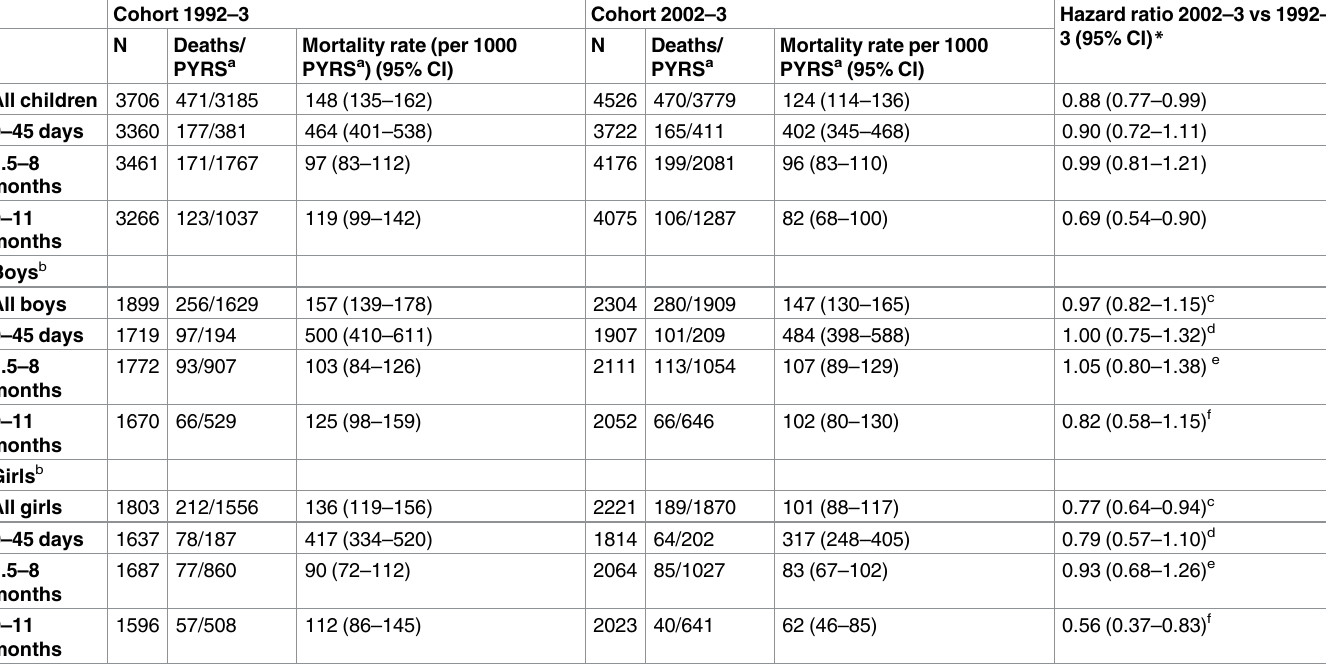
Table 1. Crude infant mortality rates in the 1992–3and 2002–3birth cohorts for all children and by age groups—Overall and by